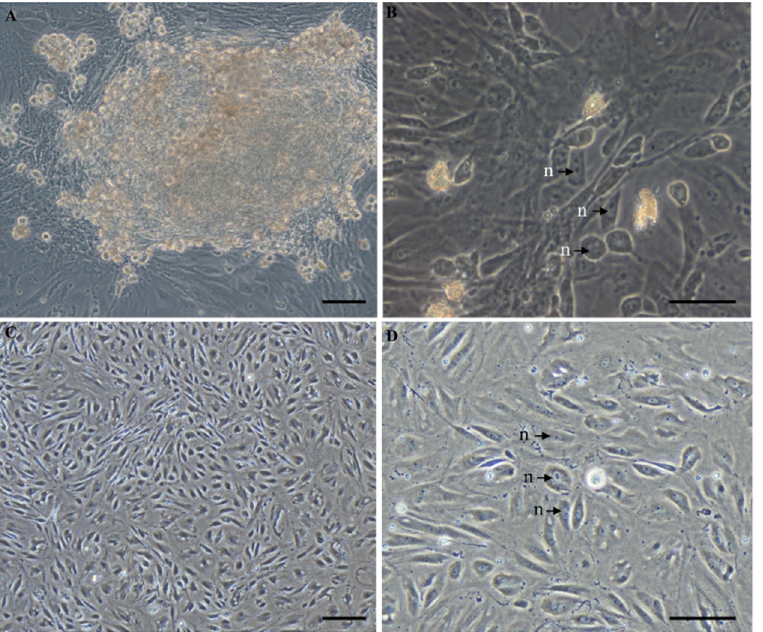
Figure 1. Morphology of ovarian cells during the in vitro culture. Morphological characteristics of the turtle ovarian cells line YTO2 were observed under an inverted microscope. ( A , B ) Ovarian cells in primary culture at Day 20. ( C ) Monolayer ovarian cells at passage 20th and Day 209th. ( D ) The cells being frozen at − 196 °C for over 180 days and being thawed for culture at passage 20th and Day 209th. Arrows indicated the cells’ nucleus. Scale bar, 100 μ m. “n” indicated the cells’ nuclear.